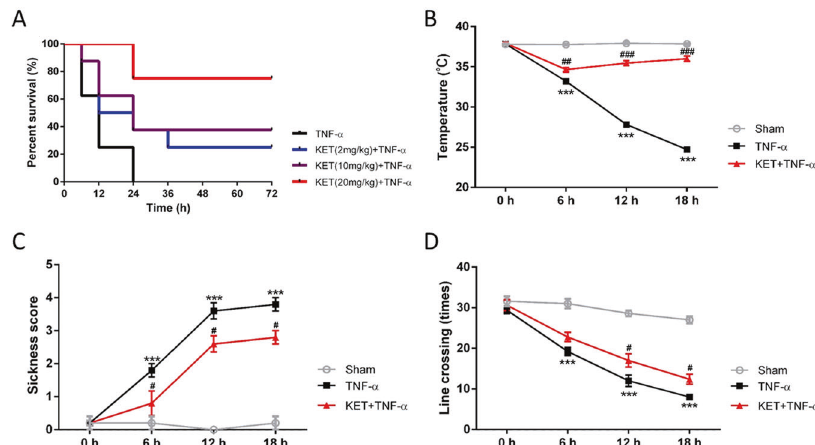
Fig. 1 Ketamine alleviated the death and sickness response induced by TNF- α in mice. A Effects of different ketamine concentrations on the survival of model animals stimulated with TNF- α . B – D The effects of ketamine (20 mg/kg) on the temperatures, sickness behaviors, and sickness scores of mice after TNF- α -induced SIRS. All data are shown as the mean ± SEM. n = 7/group. *Signi fi cantly different from the sham group; # signi fi cantly different from the TNF- α group. *** p < 0.001, # p < 0.05, ## p < 0.01, ### p <